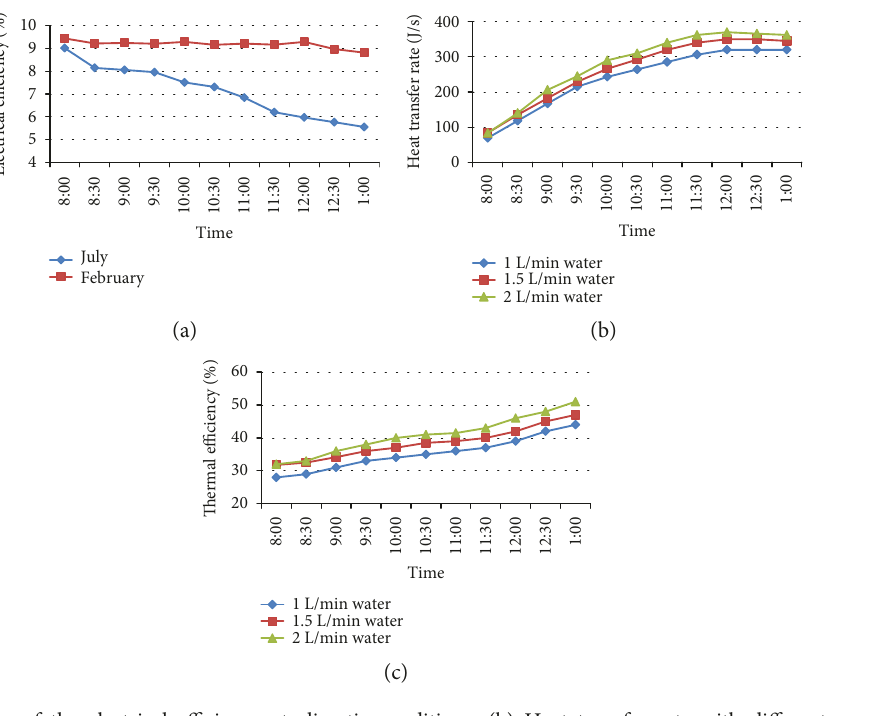
Figure 6: (a) Comparison of the electrical e ffi ciency at climatic conditions. (b) Heat transfer rate with di ff erent mass fl ow rates. (c) E ff ect of the mass fl ow rates of water on the thermal e ffi